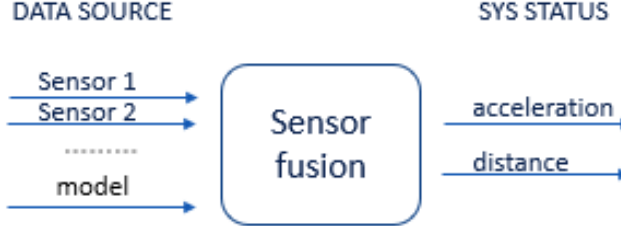
Figure 9. Fusion including data from a mathematical model.